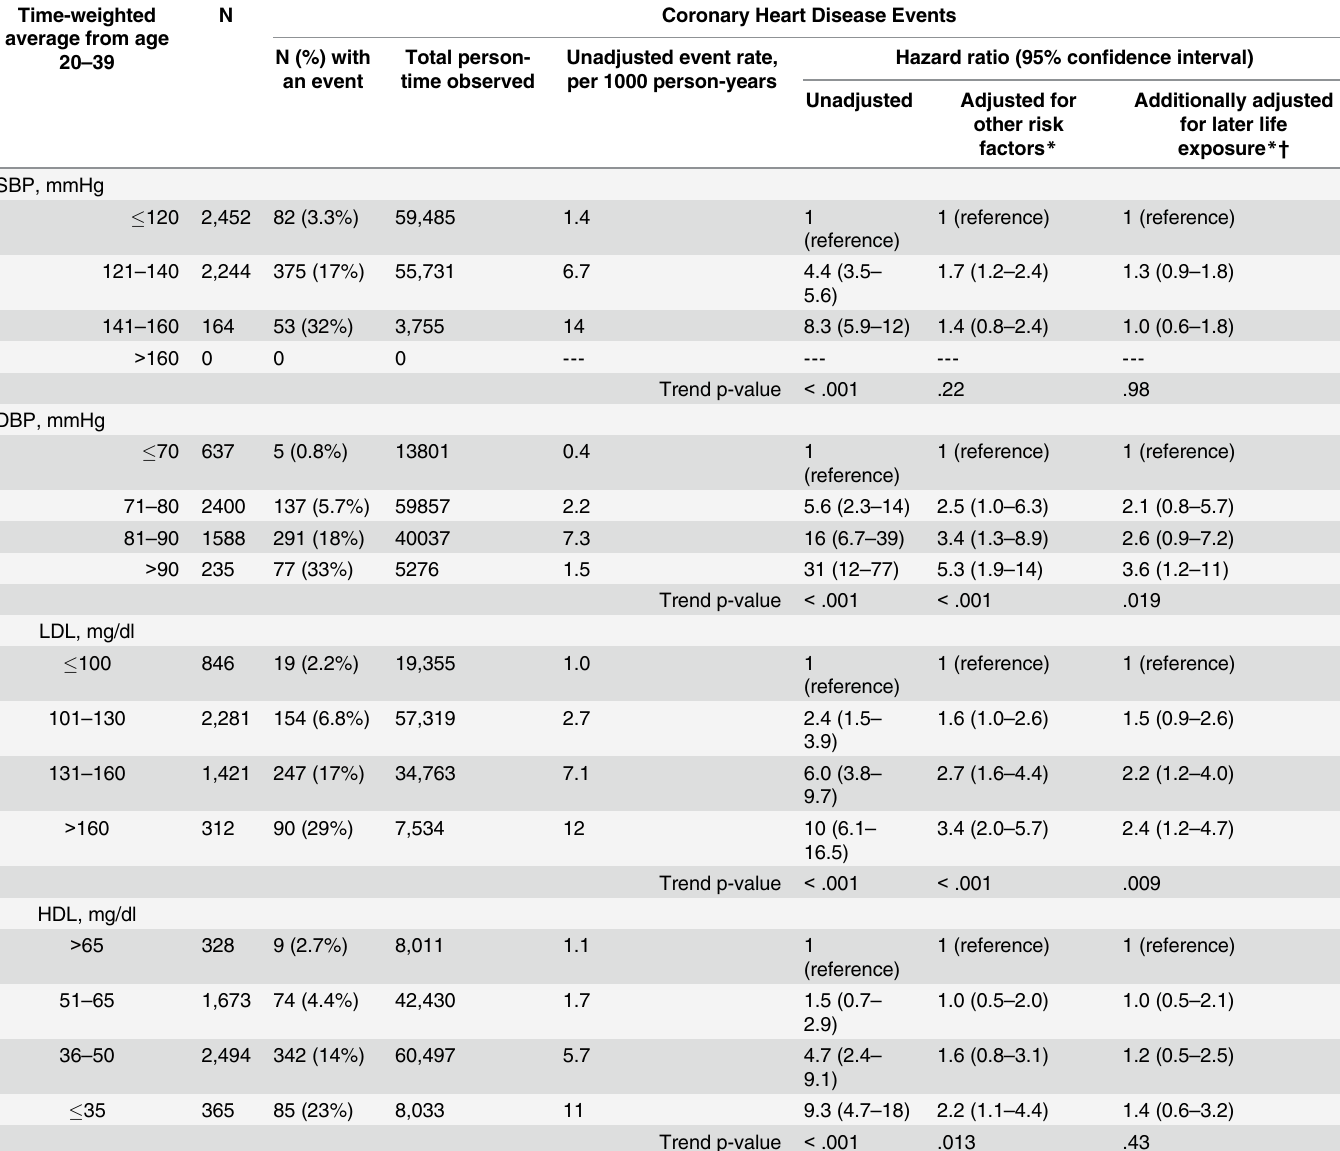
Table 3. Coronary Heart Disease Events in Framingham Participants with Differing Exposure to Risk Factors During Young